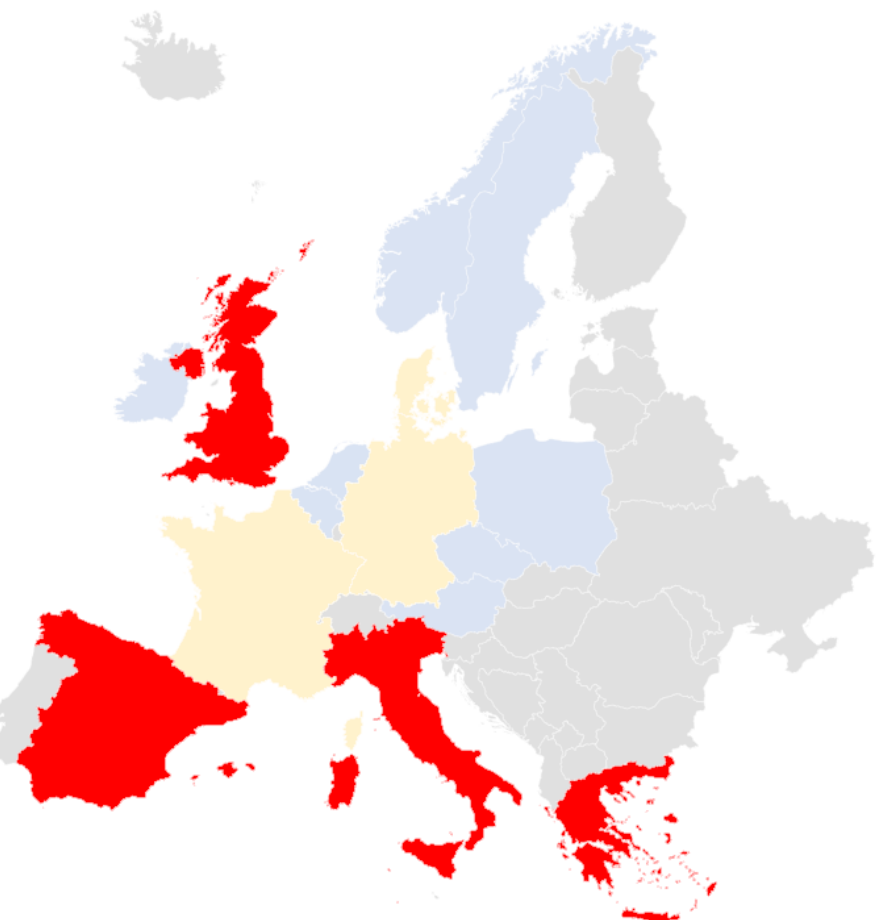
Figure 3. Principal cases of C. auris in Europe. In red: detected C. auris outbreak countries with inter-facility spreading or endemicity (Spain, Italy, Greece and the UK). In light yellow: country (Germany, France and Denmark) with sporadic outbreaks without or with only limited inter-facility spreading. In light blue: sporadic C. auris cases that were locally acquired or an unknown or imported origin [17,32,38].